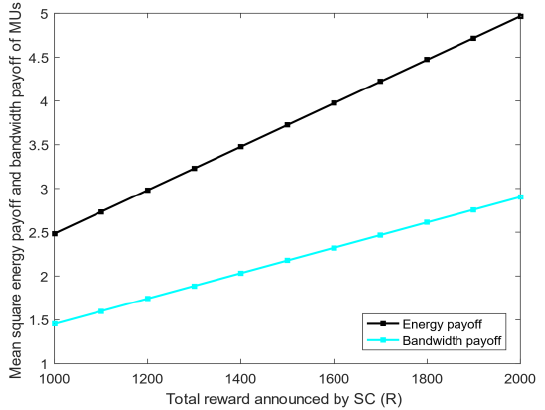
Figure 6. Variation in the mean square of MUs' energy payoff and bandwidth payoff with R .